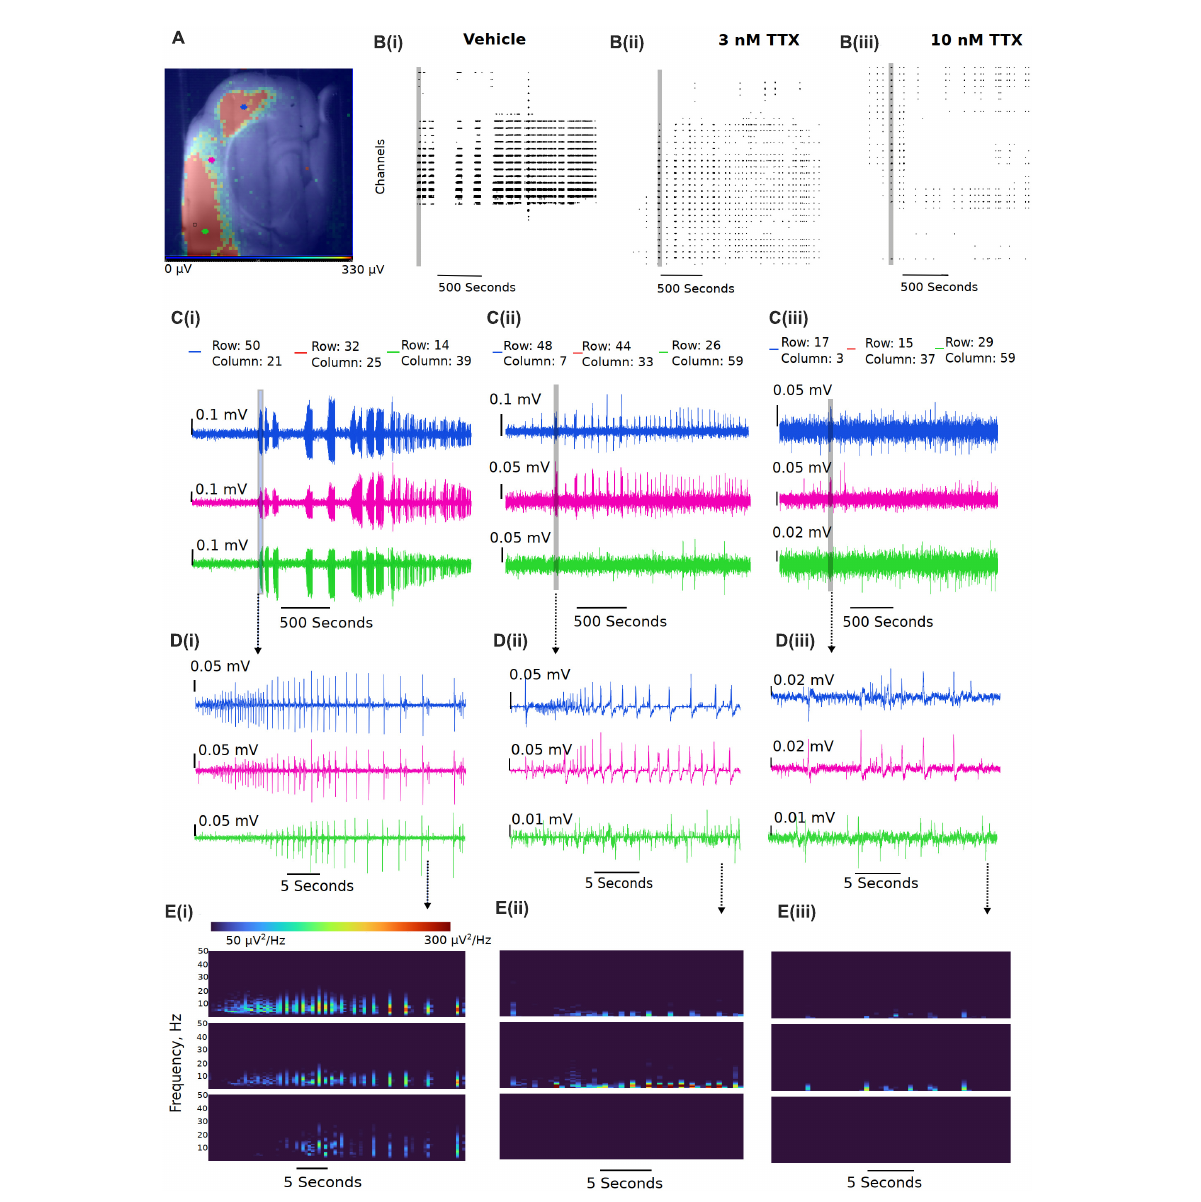
FIGURE5 Representative reduction in seizure-like events following sodium current block by TTX. (A) Example slice from a multi-electrode array recording during a seizure-like event. Colored dots (blue, pink, and green dots) represent the approximate location of the selected traces. (B) Example raster plots from the entire recordings for the (Bi) 0 Mg 2 + vehicle, the (Bii) 3 nM TTX, and the (Biii) 10 nM TTX. (C) Example traces taken from either end of the neocortical slice (blue and green traces) and a trace selected from the middle of the slice (pink trace) for the (Ci) 0 Mg 2 + vehicle, the (Cii) 3 nM TTX, and the (Ciii) 10 nM TTX. (D) Zoomed in view of the first seizure-like events from each of the three treatment groups. (E) Spectral plots of the zoomed in seizure-like events in µ V 2